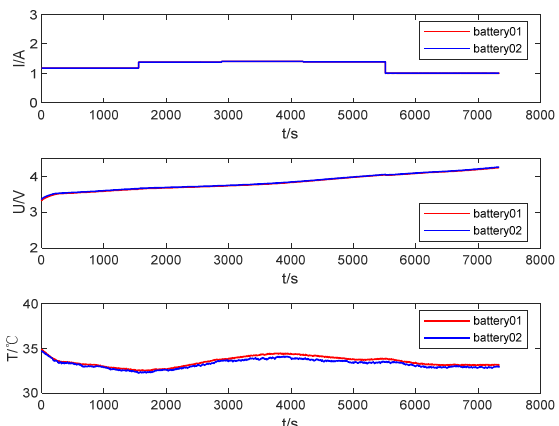
Figure 11. The experimental results of the four-stage optimized constant current charging strategy.